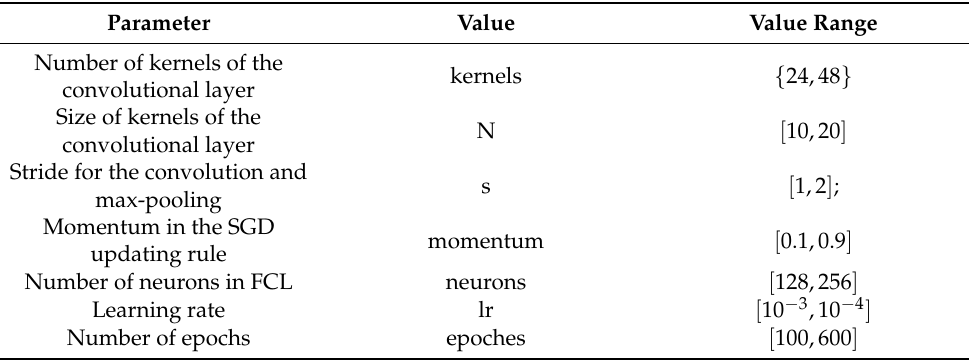
Table 1. Ranges of values for the convolutional neural network model.